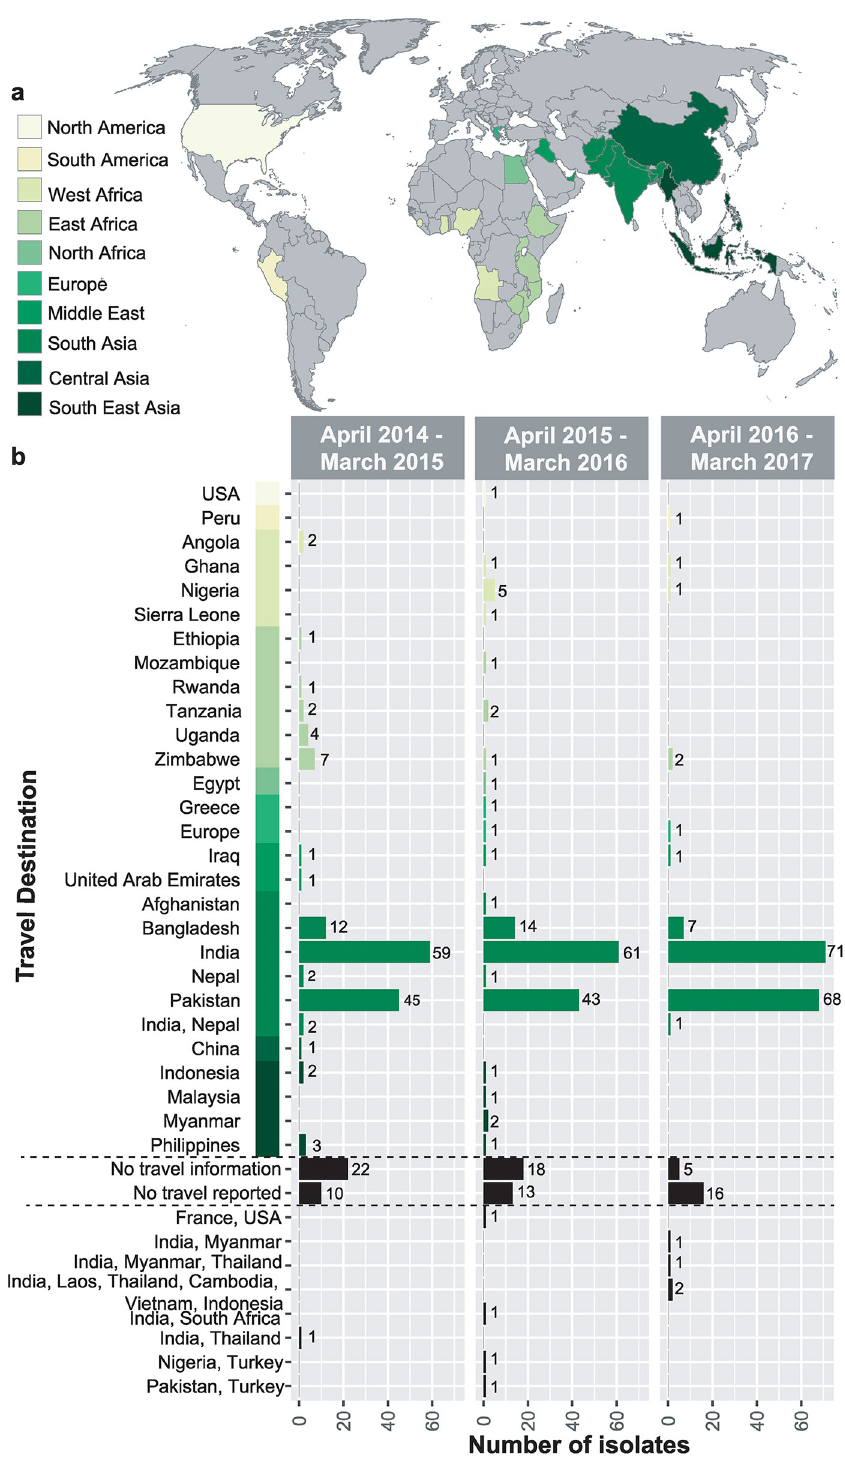
Fig 1. Summary of S . Typhi received at Public Health between April 2014 to March 2017. a) Map highlighting countries that were reported as travel destinations for patients from which S . Typhi cultures were collected. Countries are coloured by major geographical regions. Blank map sourced from https://commons.wikimedia.org/wiki/File: BlankMap-FlatWorld6.svg b) Number of S . Typhi isolates reporting travel to each country over the three-year period of study, stratified by date of receipt at